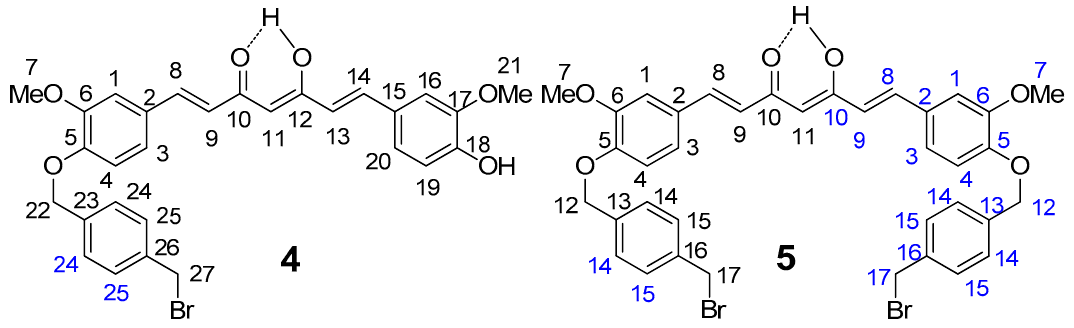
Figure 13. Structure of Compounds 4 and 5.